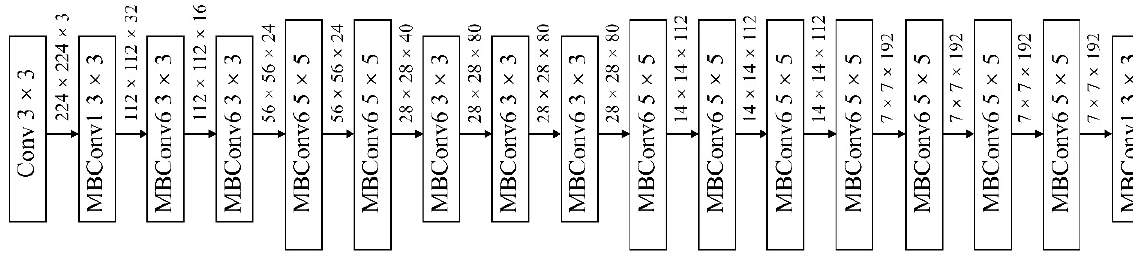
Figure 7. Baseline model EfficientNet B0.